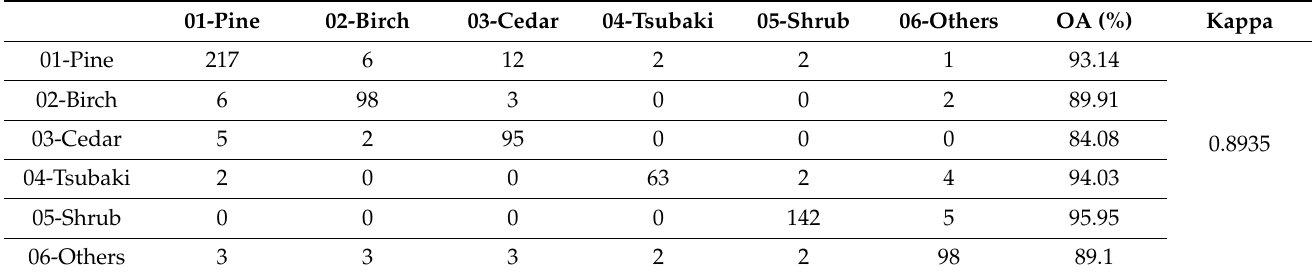
Table 6. The details of the tree species